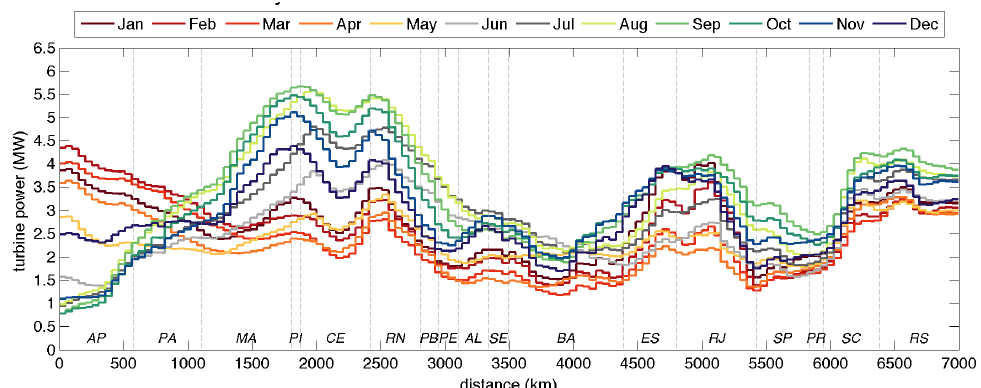
Figure 9. Turbine power P c distribution along the Brazilian coast, from Amapá (AP) in the north to Rio Grande do Sul (RS) on the southern border. Colored lines represent the monthly climatological (1987–2014) power for a Senvion 6.2 turbine. The Monin–Obukhov extrapolation method and the density correction of Equation (10) are